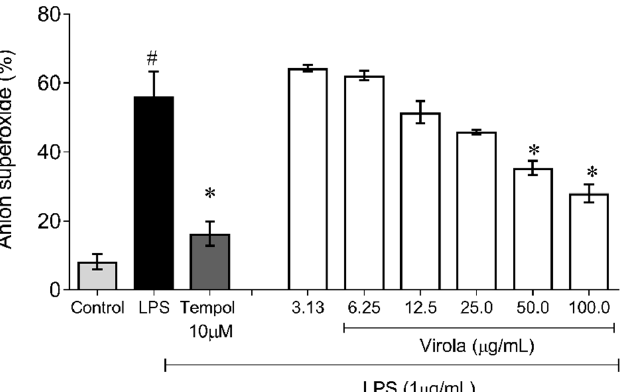
Figure 10. Lipopolysaccharide (LPS)-induced superoxide anion production showing that RV only at high doses (V50 and V100) inhibited superoxide anion induced by LPS in macrophages. Tempol: water soluble superoxide dismutase mimetic (12 mM). The values are presented as the mean ± SEM for n = 3 samples in triplicate. # p < 0.05 vs. control group. * p < 0.05 vs. LPS group (one-way ANOVA).